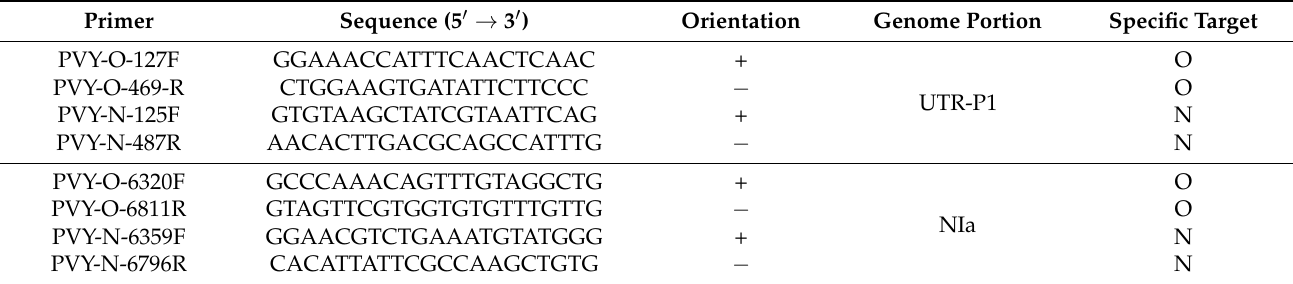
Table 4. Primer used for specific RT-PCR